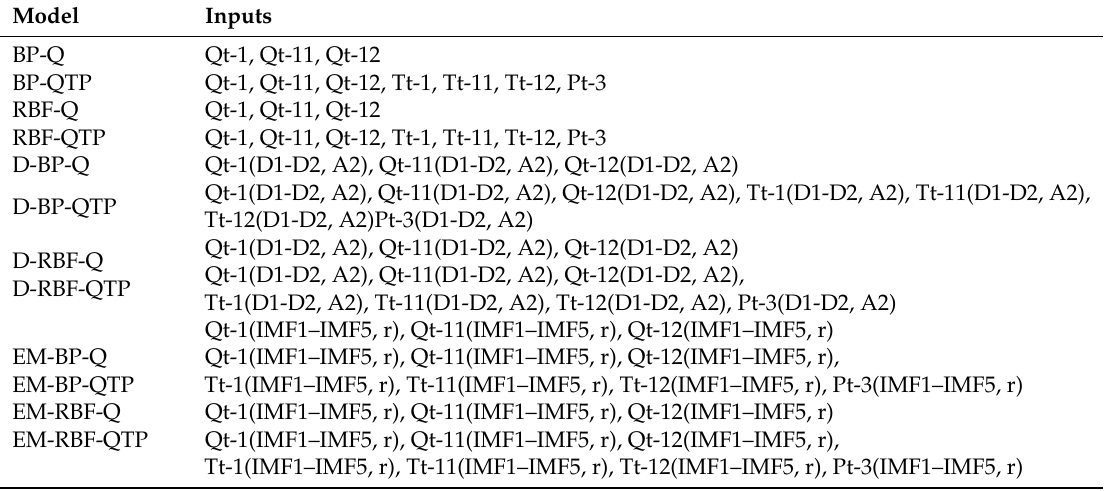
Table 4. Models and their corresponding inputs for zone